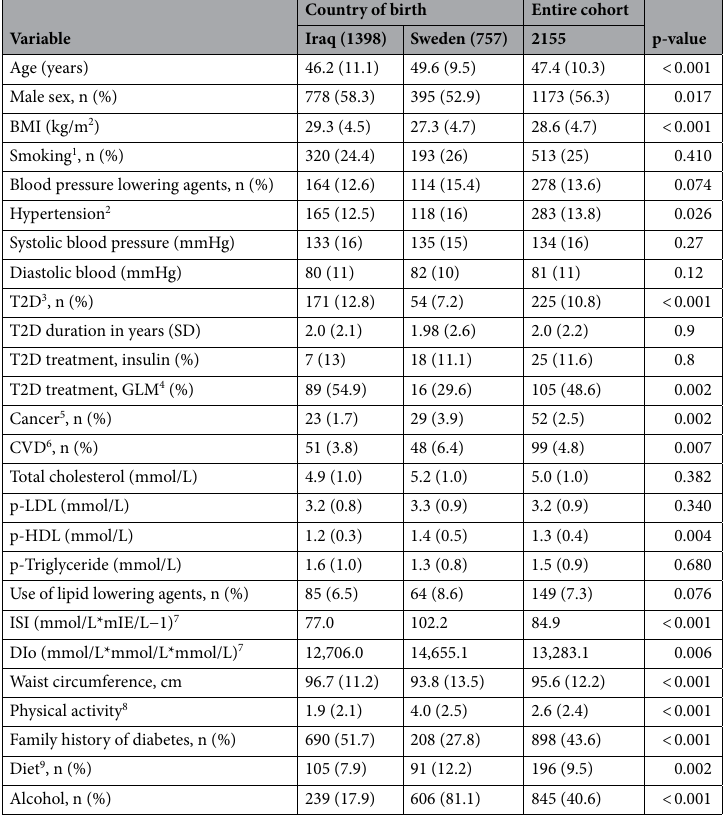
Table 1. Characteristics of study participants (Iraqi-and Swedish-born living in Malmö). Crude data are presented as means (SD) or as numbers (percentages); family history refers to parents, children and/or siblings; LDL/HDL is low-density/high-density lipoprotein. 1 Current tobacco smoking, 2 hypertension at baseline, 3 T2D at baseline, 4 glucose lowering medication, 5 cancer disease at baseline, 6 CVD at baseline, 7 differences in medians between groups, 8 hours physically active per week, 9 daily intake of fruit, berries and/or